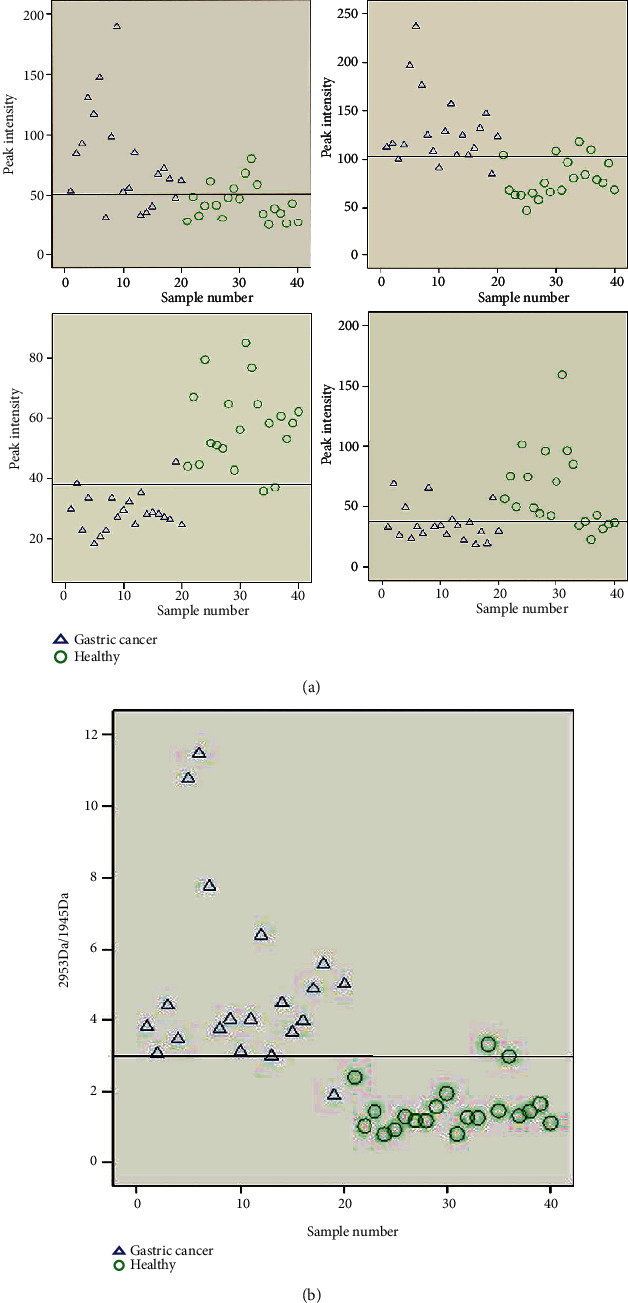
Establishment of serum peptides diagnostic model based on No.29 (2953 Da)/No.16 (1945 Da). (a) Diagnostic efficiency analysis of 4 differential peptide peaks (the horizontal line in the figure is the median numerical line). (b) The diagnostic effect of gastric cancer based on the ration of No.29 (2953 Da)/No.16 (1945 Da).